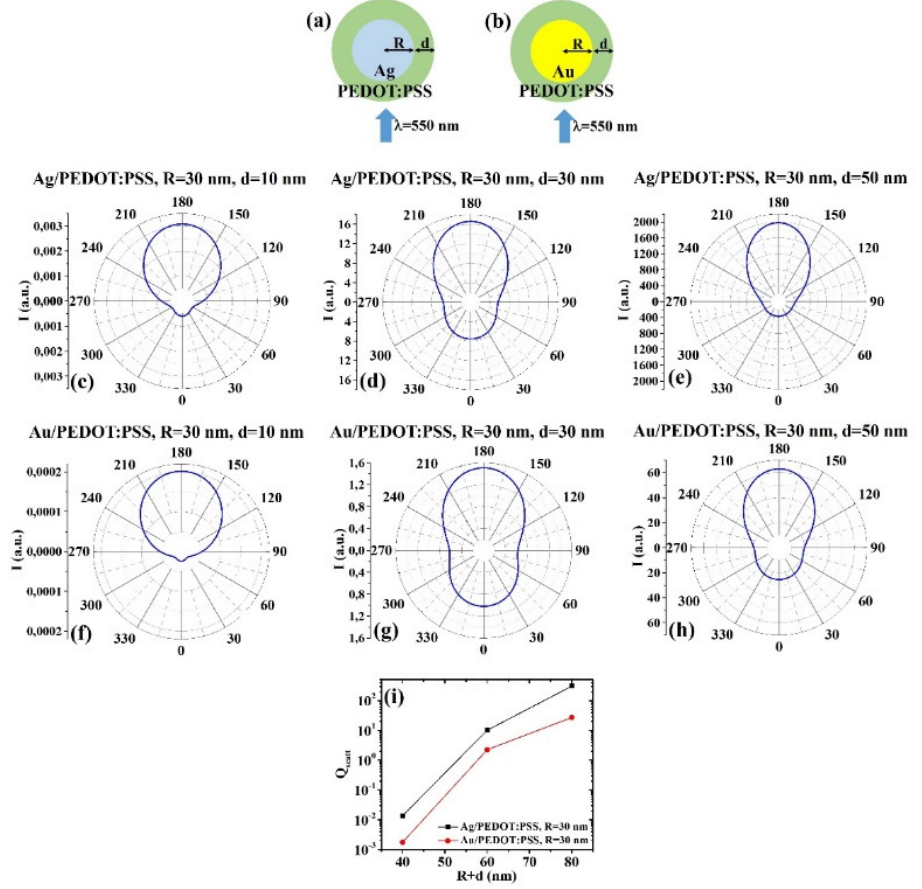
Figure 8. ( a , b ) Scheme of the structure of the simulated Ag/PEDOT:PSS ( a ) and Au/PEDOT:PSS ( b ) core–shell spherical particle with core radius R and shell width d and electromagnetic radiation of wavelength λ = 550 nm impinging on the particle from 0°. ( c – e ) Calculated polar diagrams for the intensity of the scattered light from the Ag/PEDOT:PSS core–shell spherical particle fixing the Ag core radius R to 30 nm and increasing the PEDOT:PSS shell width from 10 nm to 50 nm. ( f – h ) Calculated polar diagrams for the intensity of the scattered light from the Au/PEDOT:PSS core–shell spherical particle fixing the Au core radius R to 30 nm and increasing the PEDOT:PSS shell width from 10 nm to 50 nm. ( i ) Calculated scattering efficiency for the light (wavelength λ = 550 nm) scattering process of the Ag/PEDOT:PSS (black dots) and Au/PEDOT:PSS (red dots) core–shell spherical particles fixing the core radius to R = 30 nm and increasing the PEDOT:PSS shell width d from 10 nm to 50